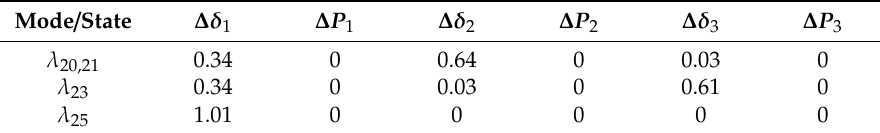
Table 5. State participation variables of dominant modes.